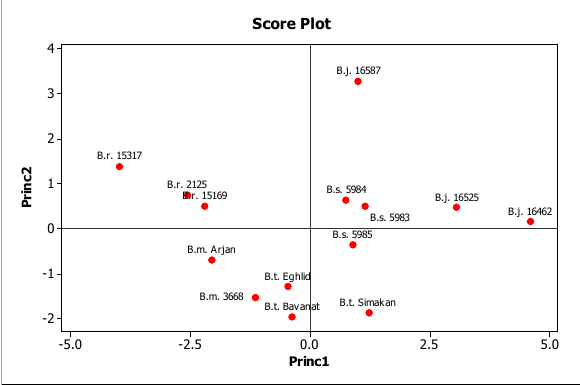
Figure 2. Scatter plot of 14 populations for the first two